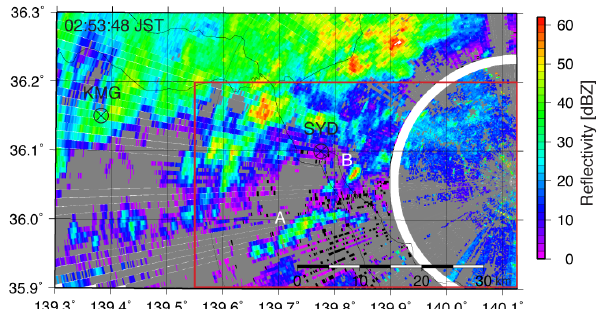
Fig. 7. Attenuation-corrected radar reflectivity field of the MRI C- band polarimetric radar at a 1.0 ◦ elevation angle at 02:53JST on 7 July 2010. The color scale represents radar reflectivity. A and B in the figure indicate convective cells, and the open circles with a cross indicate the locations of the Sekiyado (SYD) and Kuma- gaya (KMG) surface observation stations. The white circular band on the right, at 19–20.5km from the radar, is a deficit region result- ing from the alternation of short- and long-pulse observations; the red rectangle indicates the analytical area in Fig.